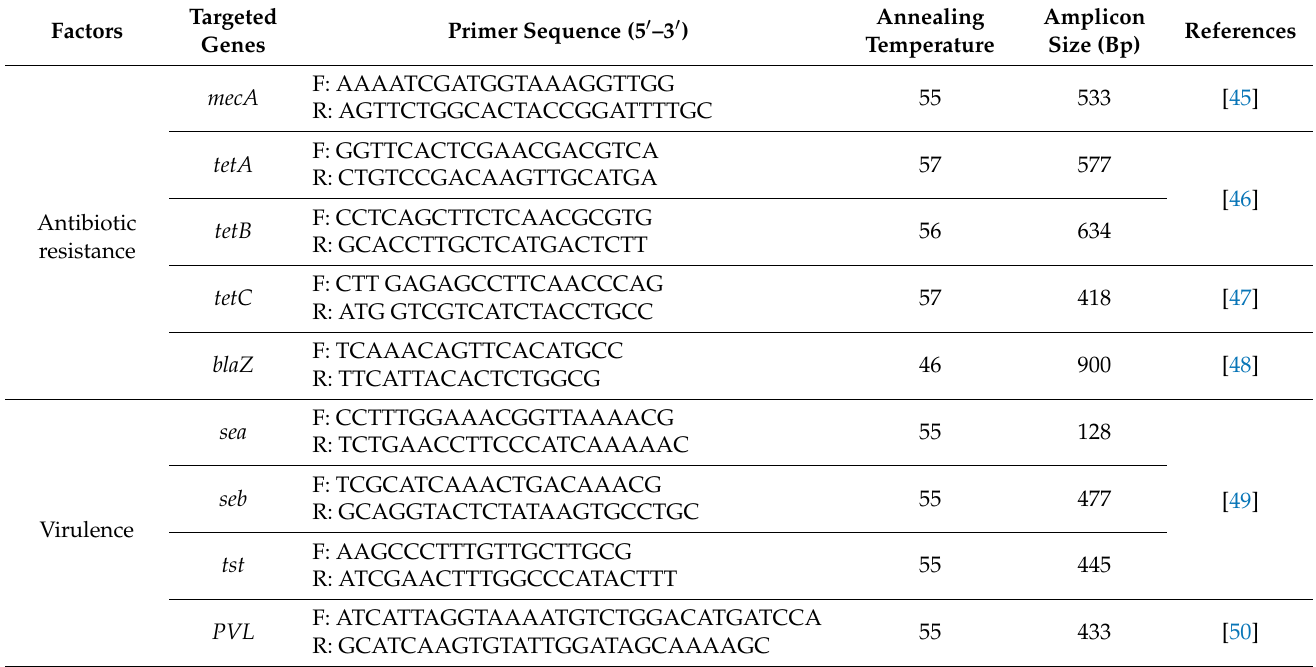
Table 6. Primers’ list associated with the virulence and antibiotic